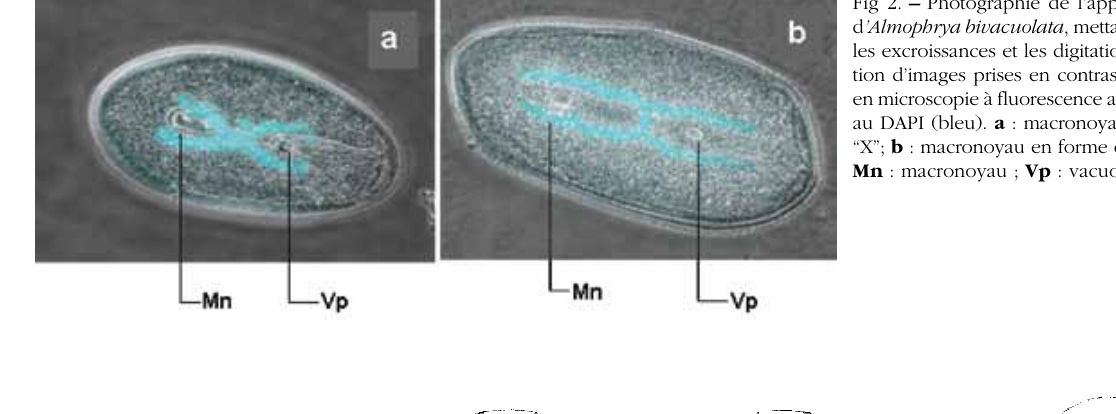
Fig 2. – Photographie de l’appareil nucléaire d ’Almophrya bivacuolata , mettant en évidence les excroissances et les digitations. Superposi- tion d’images prises en contraste de phase et en microscopie à fluorescence après coloration au DAPI (bleu). a : macronoyau en forme de